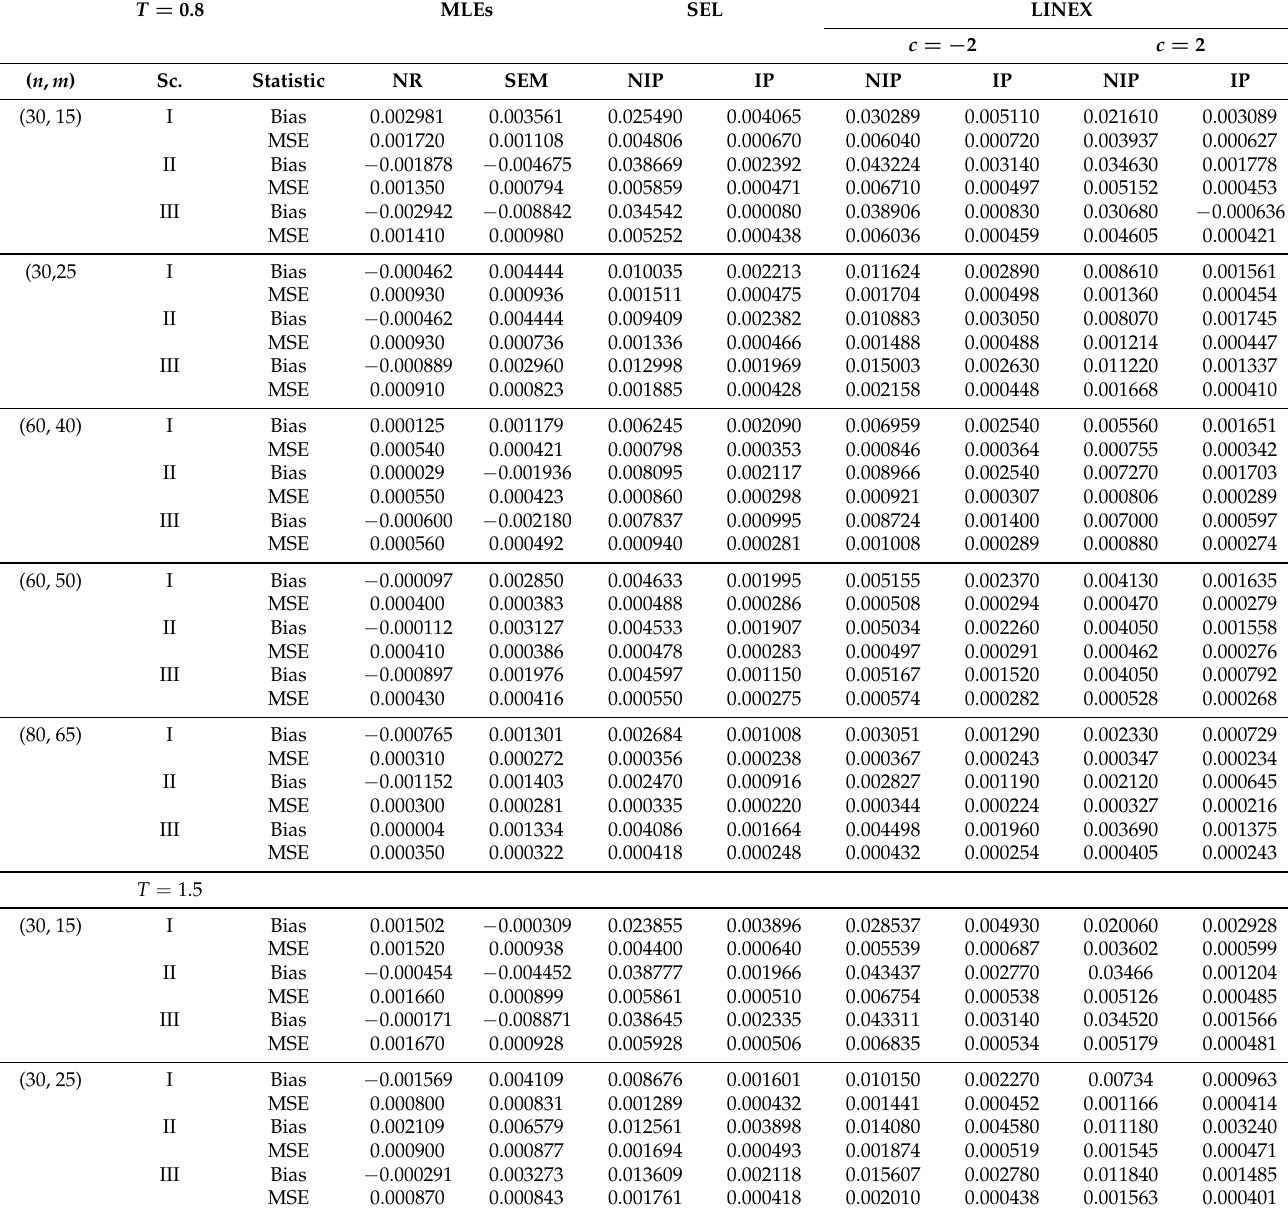
Table 8. Average values of the biases (first row) and MSEs (second row) for MLEs and Bayes estimators of θ 1 under informative prior (IP) and noninformative (NIP) prior and different censoring schemes, when ( θ 1 , θ 2 , λ ) = (0.05, 0.06,